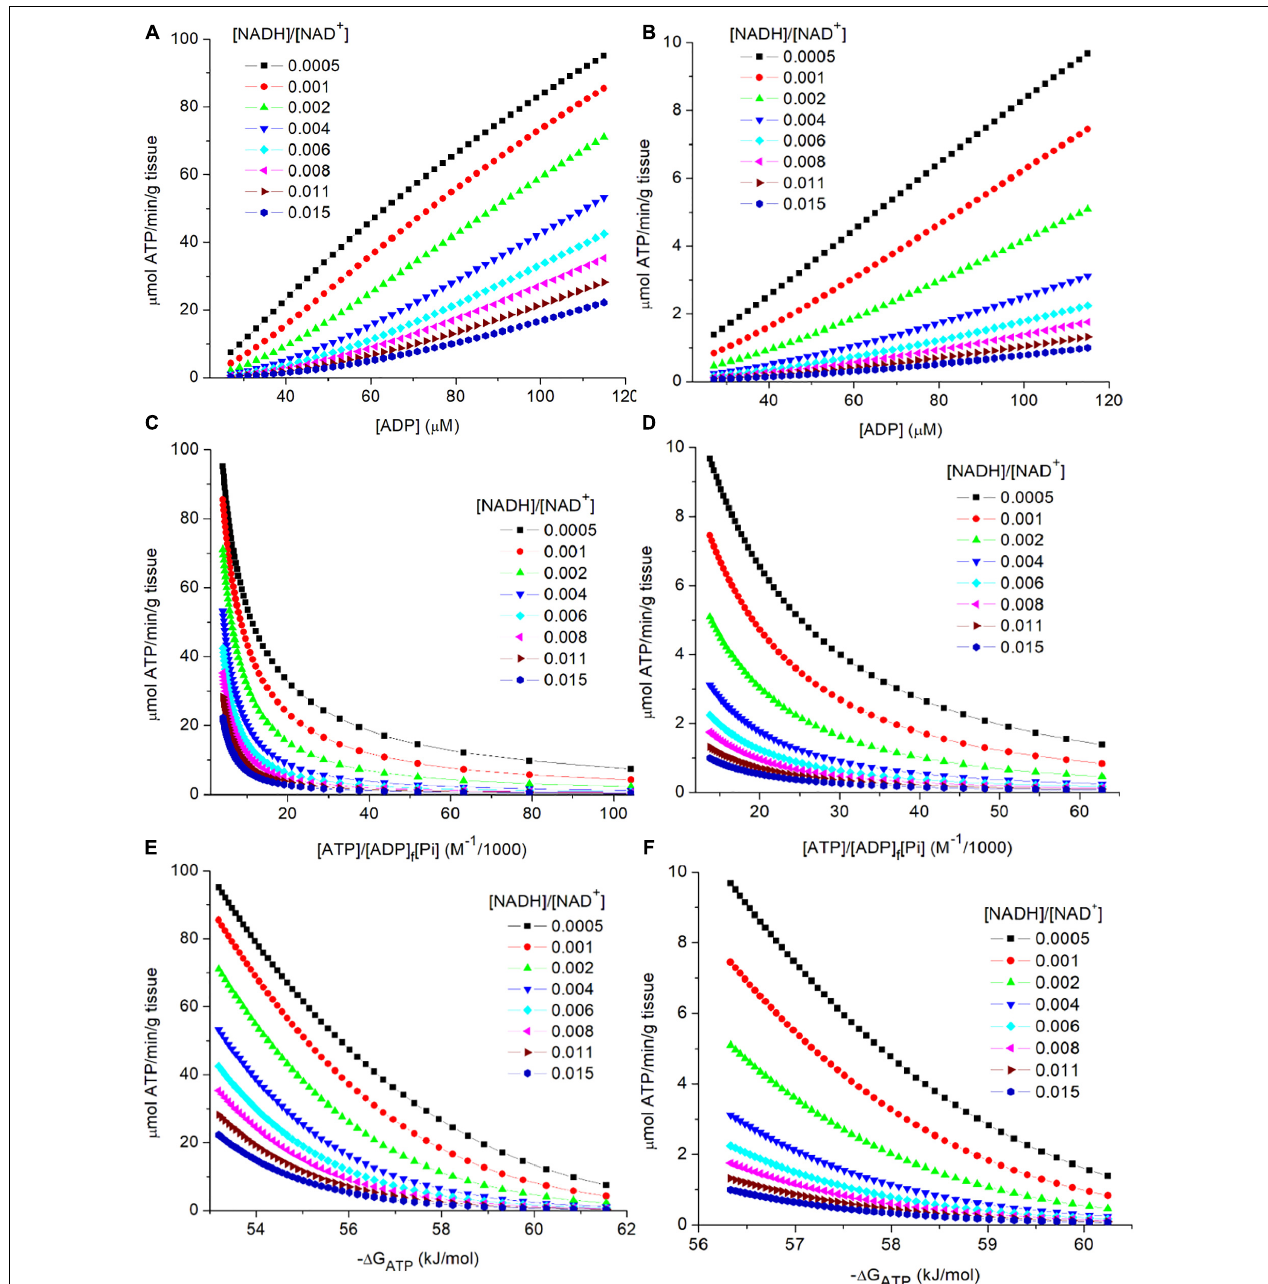
FIGURE 3 | (A–F) Simulation of the relationship of flux through PK to the metabolic variables in the preceding near equilibrium reactions. As described in the text, PK was assumed to be irreversible and to equilibrate with its substrates in a random bi bi enzyme mechanism without product inhibition. The steady state rate expression (see text equation 9). The simulated concentrations and rates are shown for 2 tissues, skeletal muscle (A,C,E) and liver (B,D,F) . The variables associated with PK (K M adp, K M pep, and the Vm) were assumed tissue specific and constant. Experimental values for [ATP] and Vm (Veech et al., 1979) were used: Vm = 387 and 50 µ moles/min/g wet weight and [ATP] = 8and 3.4 mM for skeletal muscle and liver, respectively. Simulations for skeletal muscle, but not liver, included equilibrium of the creatine kinase reaction. The simulated range in [ADP] f (27 to 115 µ M) corresponds to a range in [CrP]/[Cr] of 2 to 0.5. [G-3-P] was assumed to be constant at 8 µ M, and [Pi] was set to be near 4 mM when the [CrP]/[Cr] was near 2 (resting muscle). Note that [PEP] is proportional to [G-3-P], other variables held constant, so the dependence on [G-3-P] s not presented. The simulations were carried out using MatLab (www.mathworks.com). (A,B) presents the relationship of flux through PK to [ADP] f for cytoplasmic [NADH]/[NAD + ] values from 0.0005 to 0.015 for skeletal muscle (3A) and liver (3B). (C,D) presents the relationship of flux through PK to the calculated energy state ([ATP]/[ADP] f [Pi]) for cytoplasmic [NADH]/[NAD + ] values from 0.0005 to 0.015. (E,F) presents the relationship of flux through PK to the free energy of hydrolysis of ATP ( − (cid:49) G ATP ) at cytoplasmic [NADH]/[NAD + ] values from 0.0005 to 0.015.